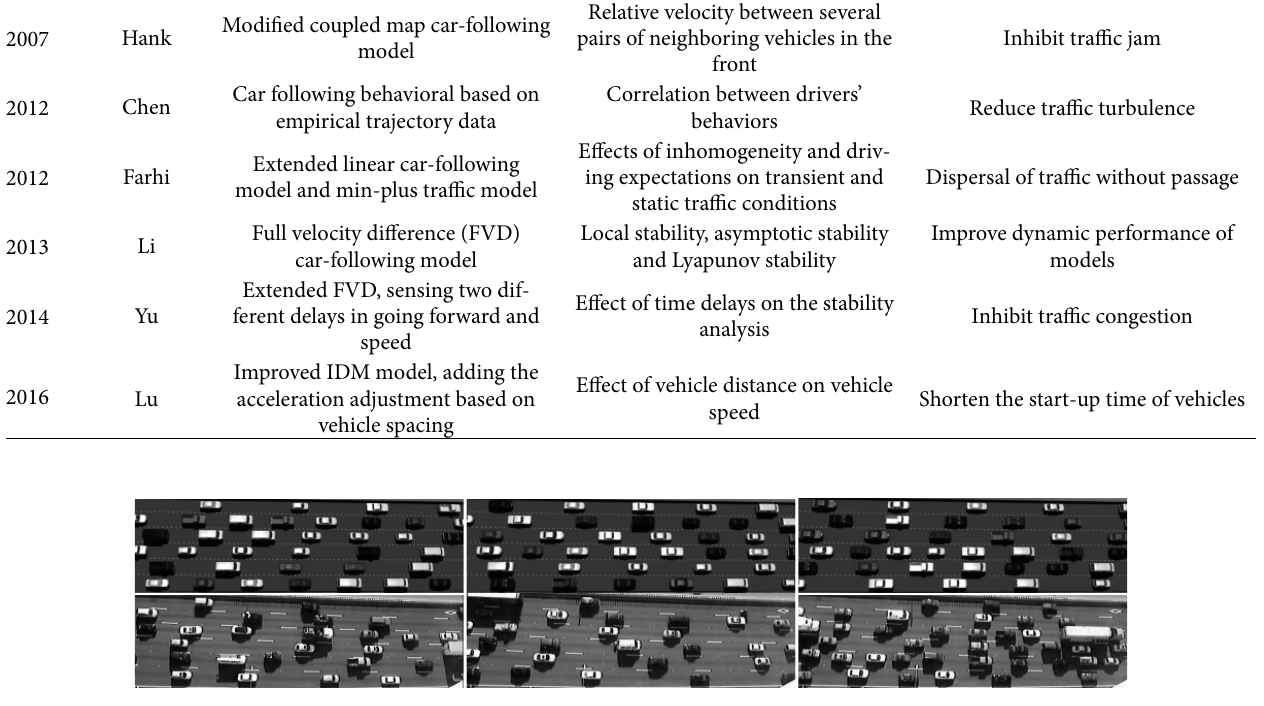
Figure 1: Reconstruct traffic flow according to the video data.